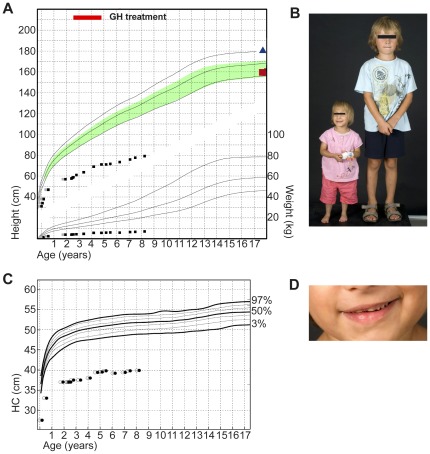
Clinical data of the patient.A, Growth and weight charts of the patient. On the growth chart solid lines indicate 97th, 50th and 3rd percentiles; the shaded green area exhibits target height calculated from parent's height (blue triangle, father's height; red square, mother's height); red bar assigns period of rhGH therapy; grey squares mark the corrected age for preterm infants. B, Photograph of the patient at the age of 5.7 yrs. in comparison to a 5.8 yrs. old boy. C, Head circumference (HC) chart of the patient; 97th, 50th and 3rd percentiles are indicated as black solid lines, white circles mark the corrected age for preterm infants. D, Photograph of the patient's hypoplastic teeth.